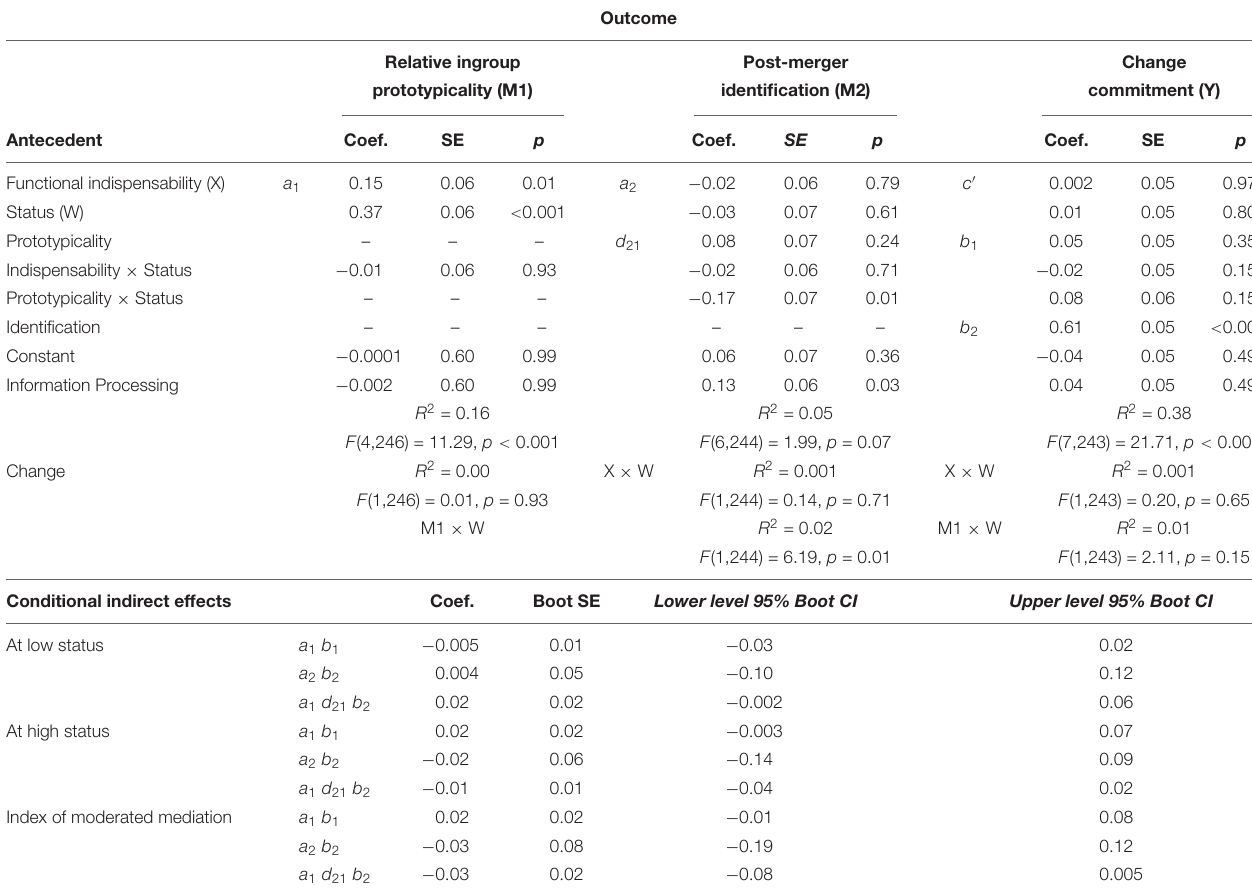
TABLE 4 | Summary of sequential mediation, Study 3 (moderated by